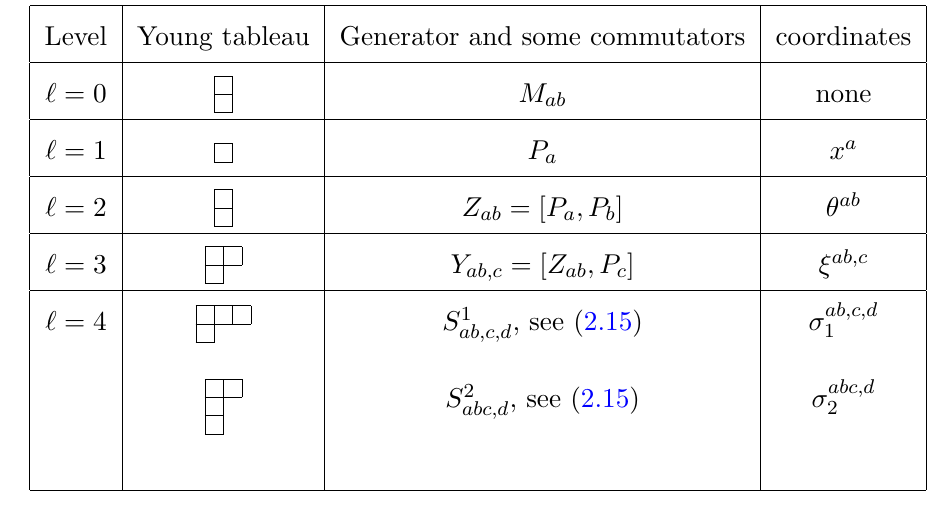
Table 1 . Summary of the low level generators of Maxwell 1 in D = 4 dimensions. The Young tableau describes the tensor type as a representation of the symmetric group. All generators are Lorentz tensors under the anti-symmetric M ab . Levels ‘ = 0 and ‘ = 1 together constitute the Poincar(cid:19)e algebra and the translation generators P a generate the higher levels freely (in a Lie alge- braic sense). We also display the coordinates that are associate with the generators in the non-linear realisation of Maxwell 1 =